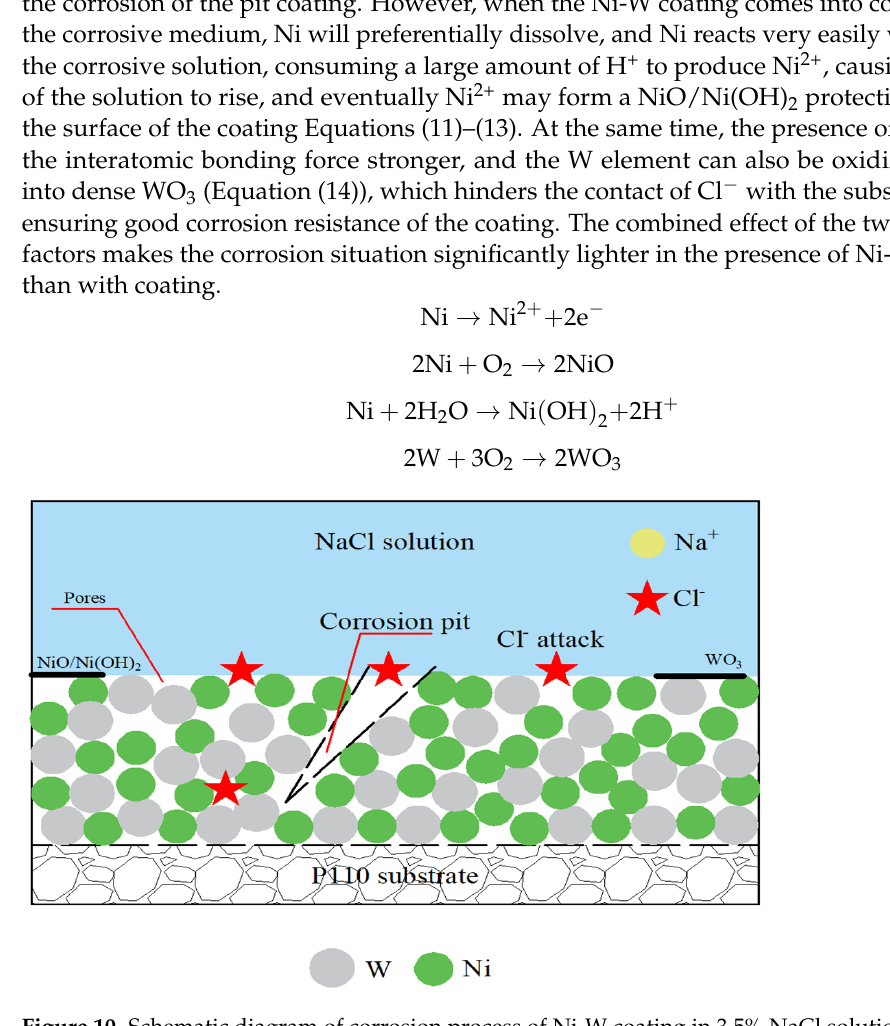
Figure 11. Schematic diagram of corrosion process of Ni-W-CF coating in 3.5% NaCl solution.